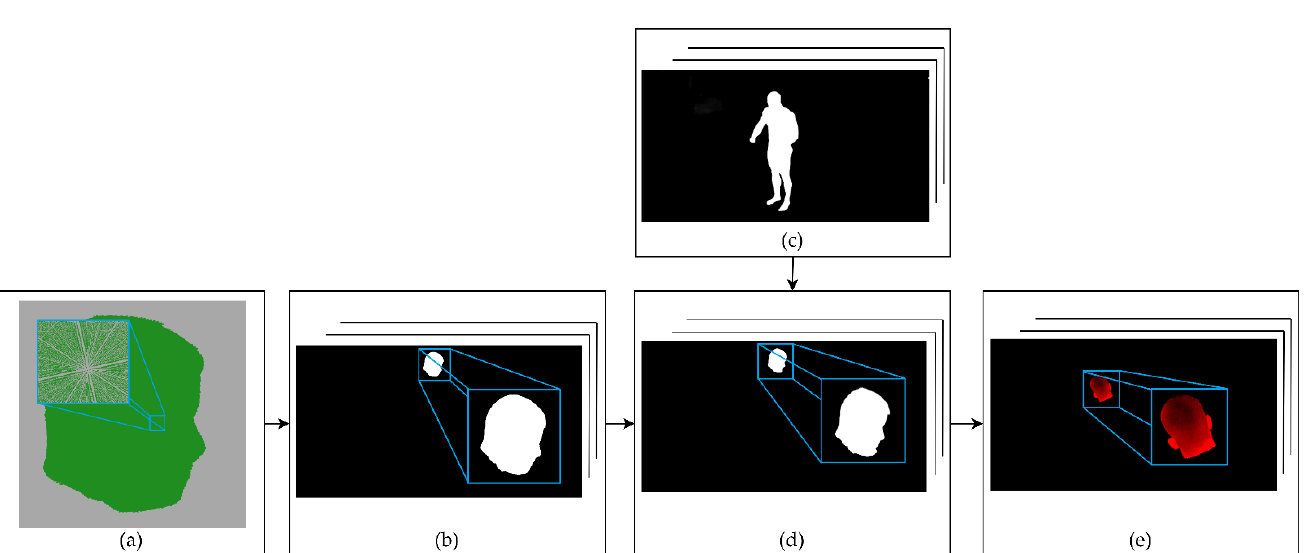
Figure 6. The estimation of the body segment silhouettes and their volumetric reconstructions. ( a ) Segment from the initial coarse volumetric reconstruction step with a 4 mm voxel size. ( b ) Projection of the voxels from the segment reconstruction onto the camera images for all the system’s cameras. The pixels where the projection was performed are changed to a value of 255. ( c ) Input silhouettes of the subject’s entire body from a set used to estimate an initial visual hull reconstruction. ( d ) Body segment detection for all silhouette images. The projection from step ( b ) is used as a mask for the segment on the silhouette image. ( e ) Detection of erroneous silhouettes by calculating the ratio of the segment projection pixels to the uncertain silhouette pixels, with values in the range <1, 254>.